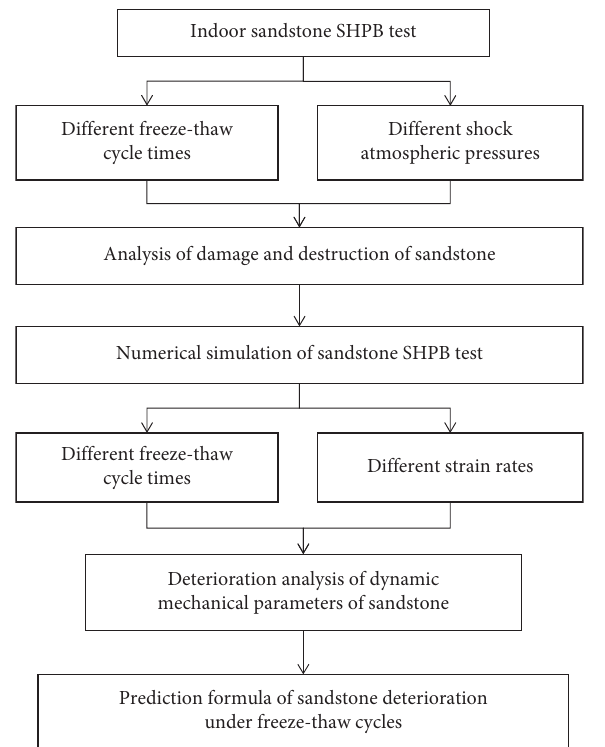
Figure 1: Specific flowchart of research